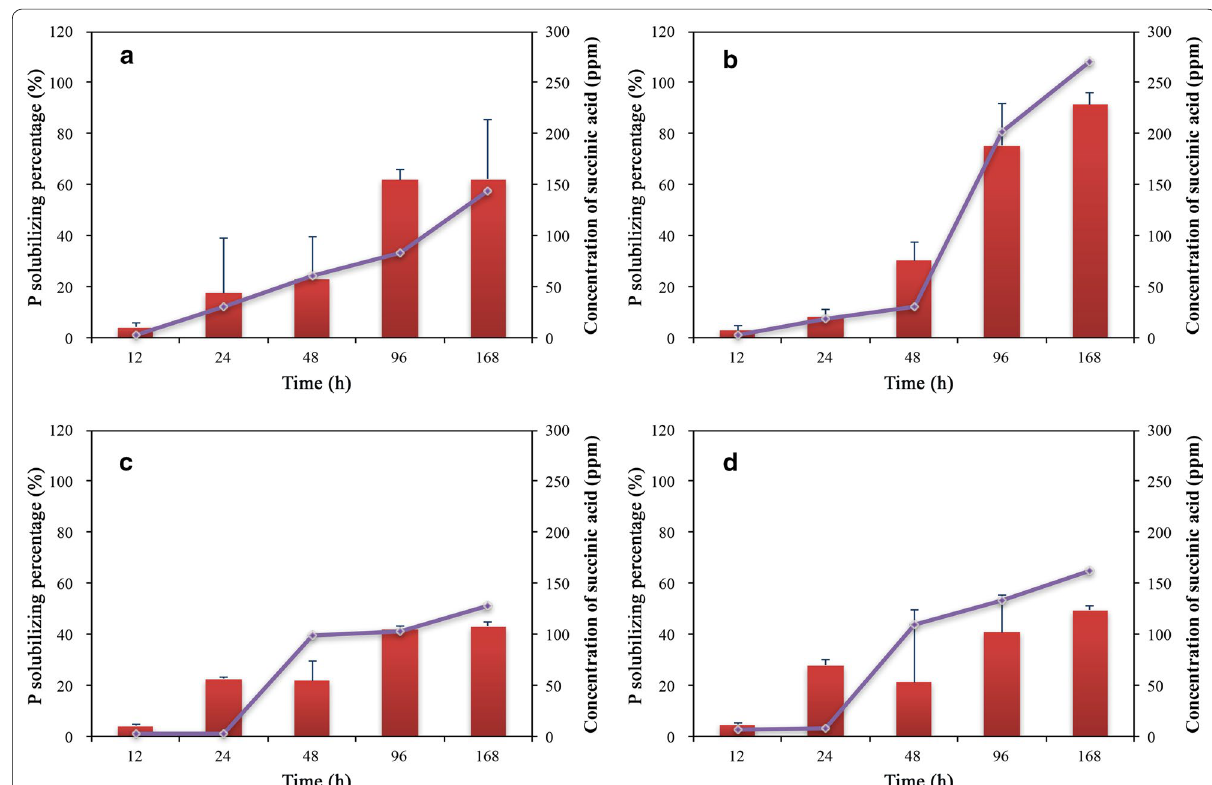
Fig. 4 The P‑solubilizing percentages (red bars) and succinic acid production (purple lines) for the four representative iPSB strains over 168 h of growth. a B. megaterium Y1412, b B. megaterium Y99, c B. megaterium Y95 and d B. megaterium Y924. Each value represents the mean of three repli‑ cates standard ±